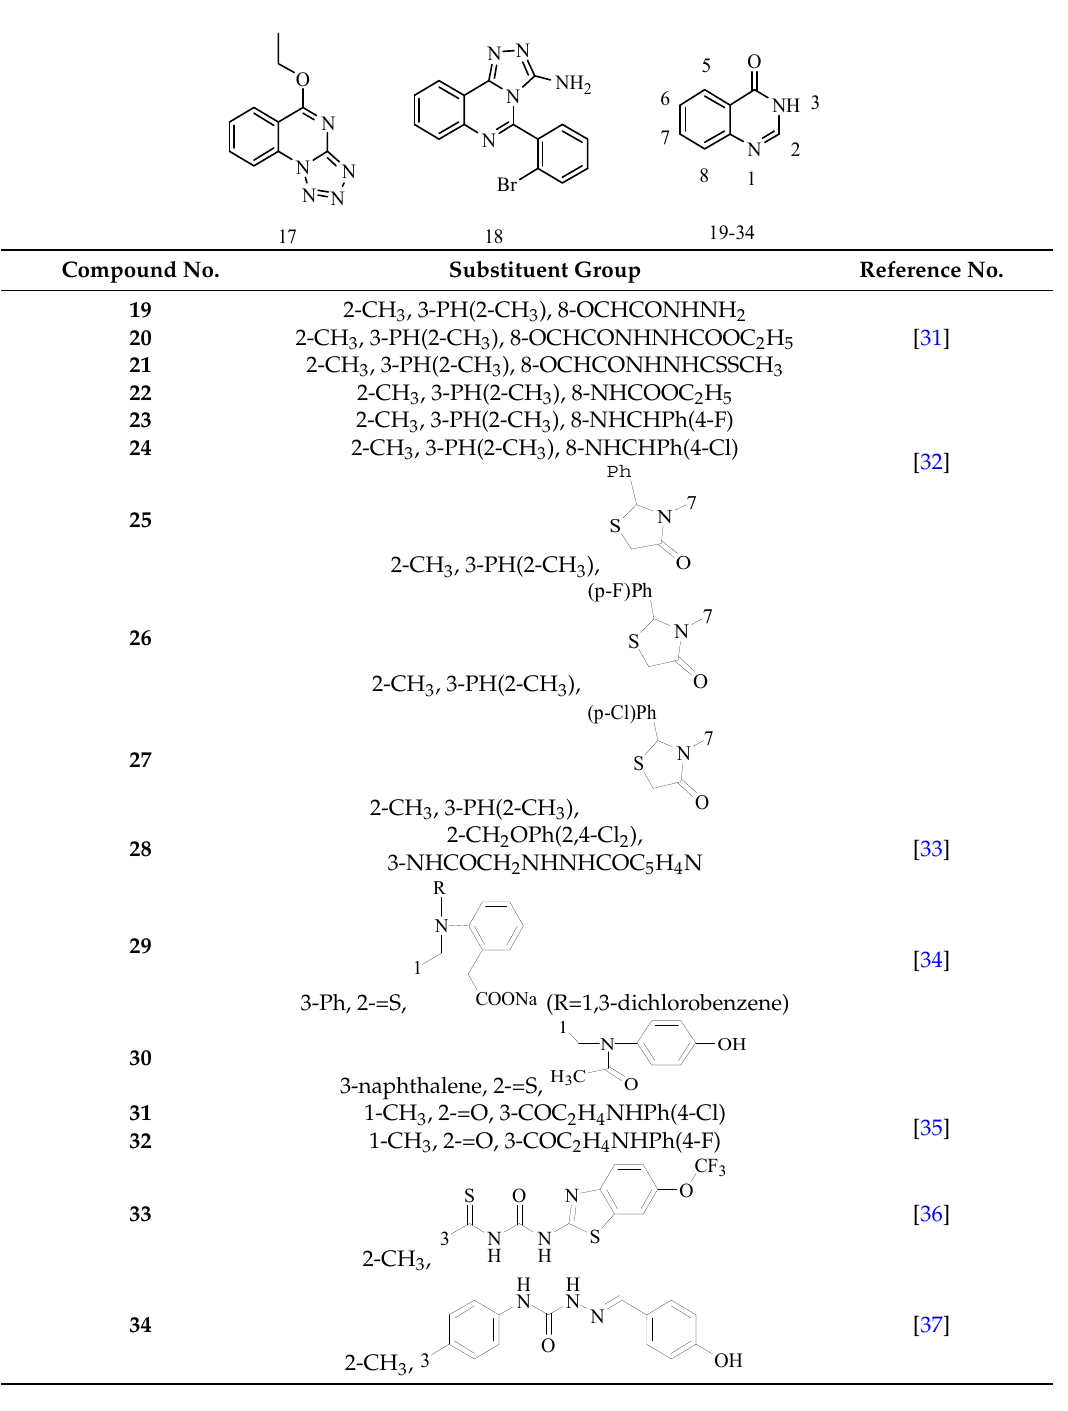
Table 2. Anticonvulsant activity of quinazoline or quinazolinone compounds.